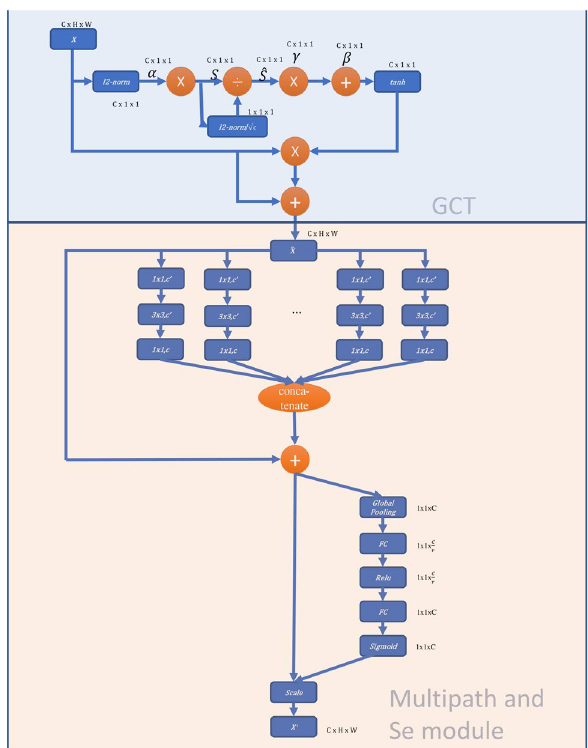
Fig. 1 Dual-attention block